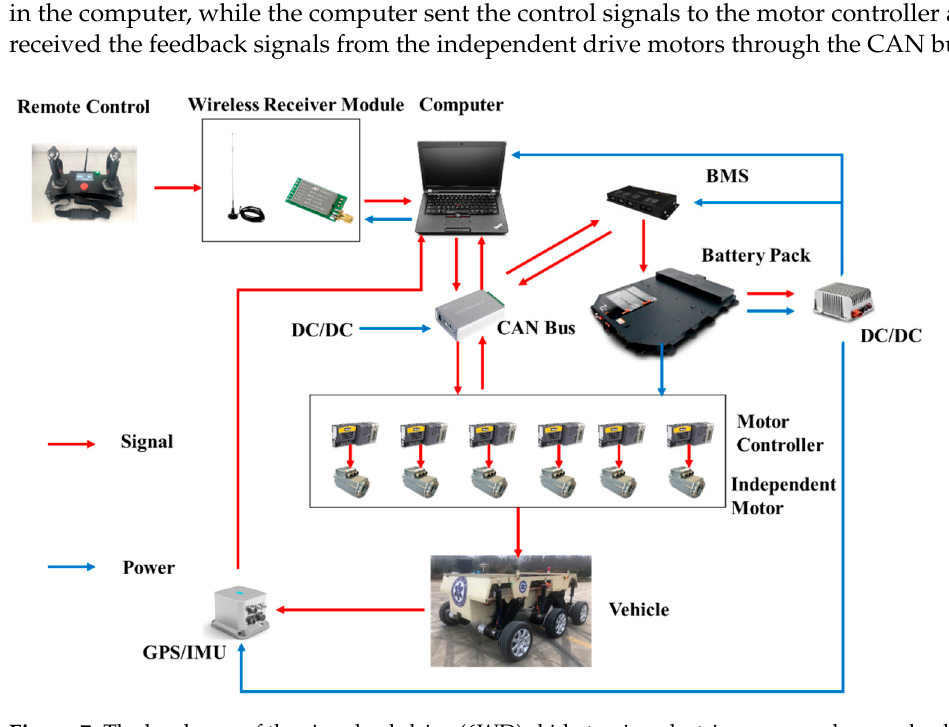
Figure 7. The hardware of the six-wheel-drive (6WD) skid-steering electric unmanned ground vehicle (EUGV) platform.